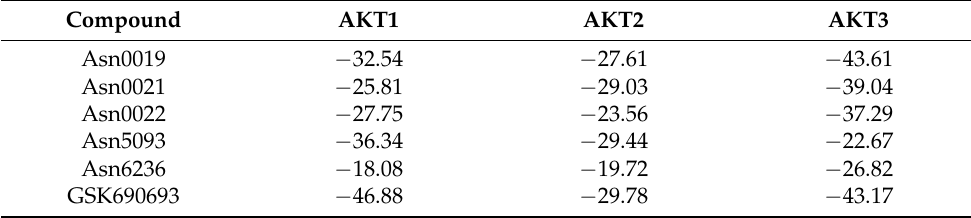
Table 10. Calculated binding free energies ( ∆ G bind in kcal/mol) for the AKT1, ATK2, and ATK3 bound